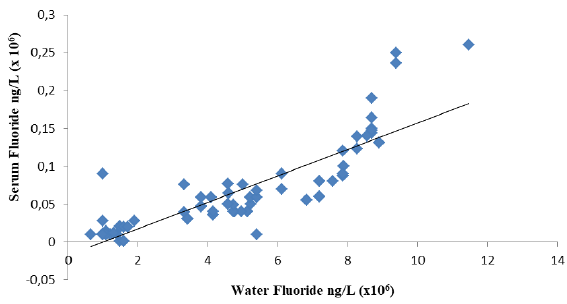
Figure 2: Relationship between Water and Serum Fluoride of RM Participants r =0.86.